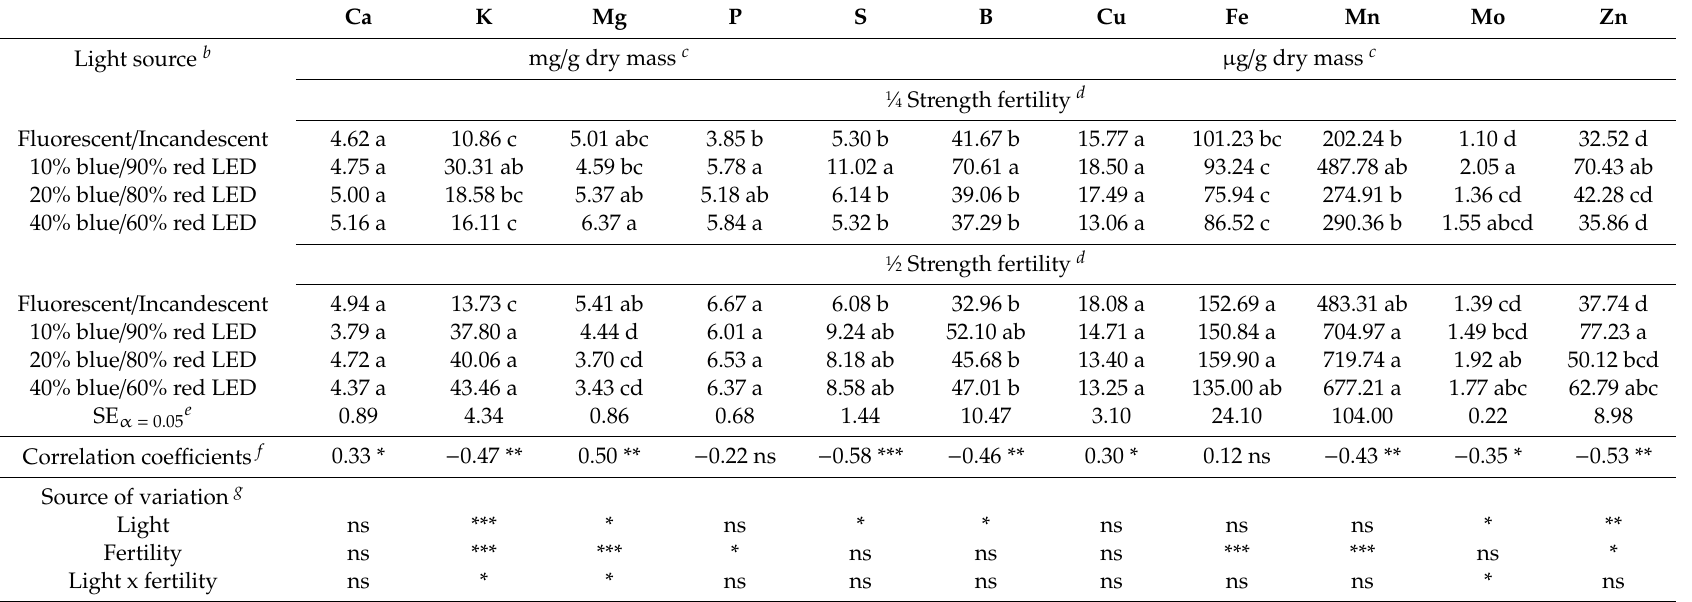
Table 2. The e ff ects of four light quality and two fertility treatments on root tissue mineral element concentrations for “Green Lance” Chinese kale ( Brassica oleracea var alboglabra ) grown in controlled environments a